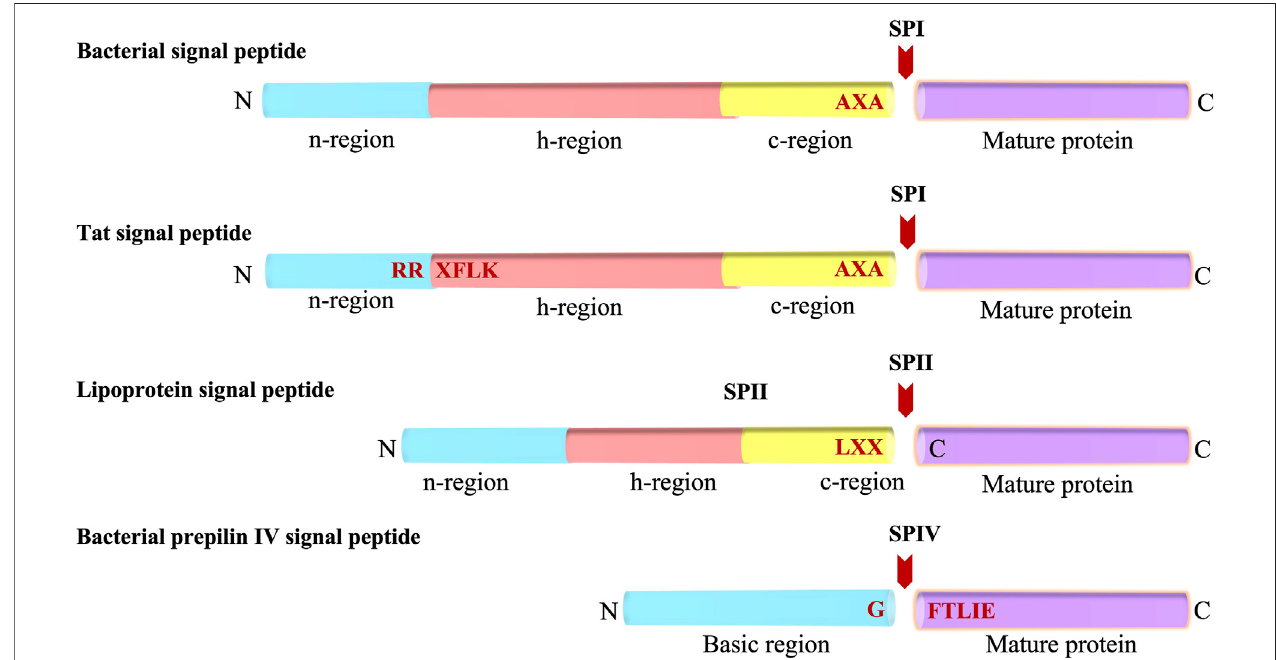
FIGURE 1 | Bacterial Signal peptides. Schematic representations of the Sec-type signal peptide, the twin-arginine (Tat) signal peptide, the lipoprotein signal peptide,andtheprepilinsignalpeptide.Thevariousregionsofthesignalpeptides(n,h,candbasicregions)areindicated.TheSPcleavagesiteisrepresentedwithared arrow. N and C indicates amino and carboxyl-terminus,